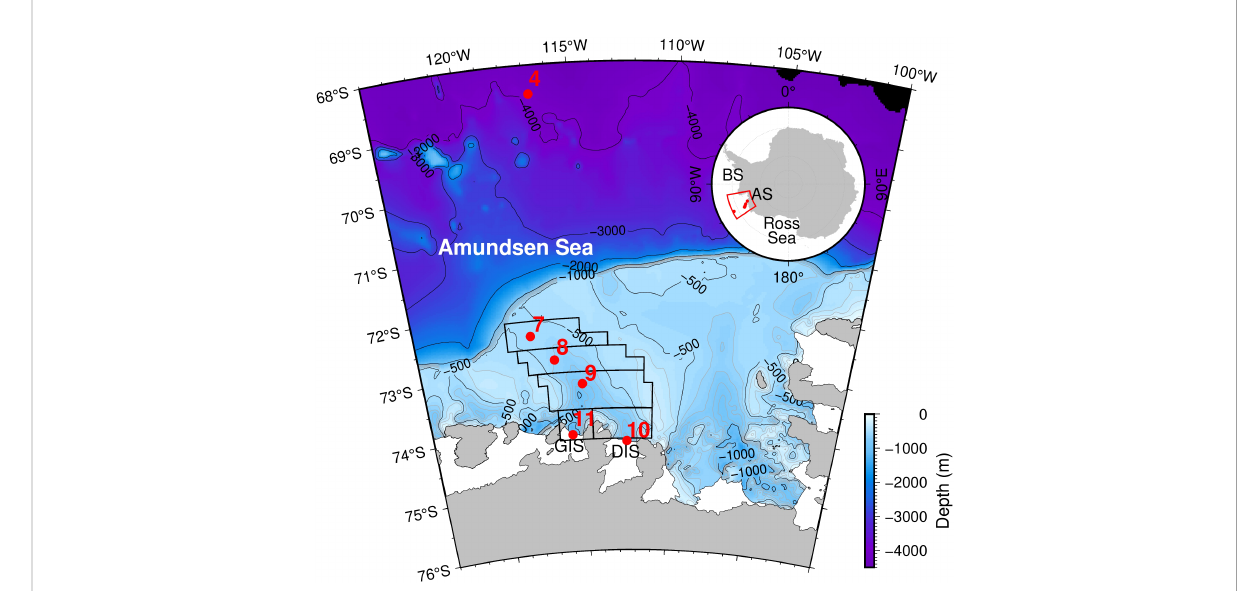
FIGURE 1 Map depicting sampling locations. The Amundsen Sea (AS) is situated between the Ross and Bellingshausen Seas (BS in the inset). Water samples for the noble gas analysis were collected along the Dotson-Getz Trough (DGT), which links modi fi ed circumpolar deep water (mCDW) to the Dotson and Getz Ice Shelves (DIS and GIS). Red circles indicate sampling locations. Black polygons depict the areas considered for calculating the volume of the Dotson-Getz Trough for the melting rate calculation as mentioned in Section